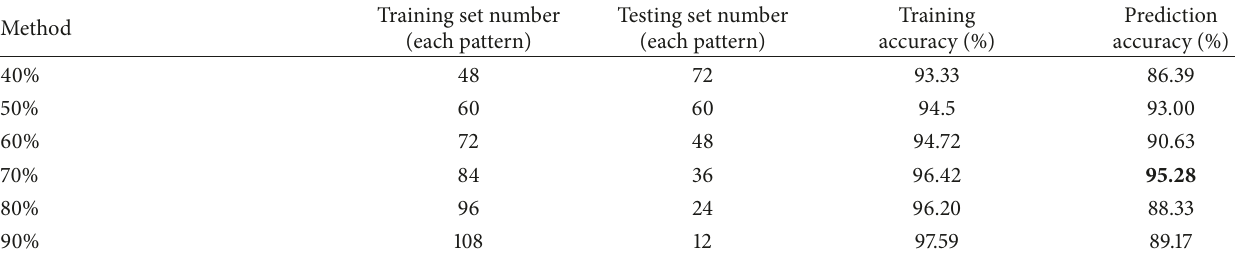
Table 7: The optimal values of the MSVM classifier parameters for different training samples.